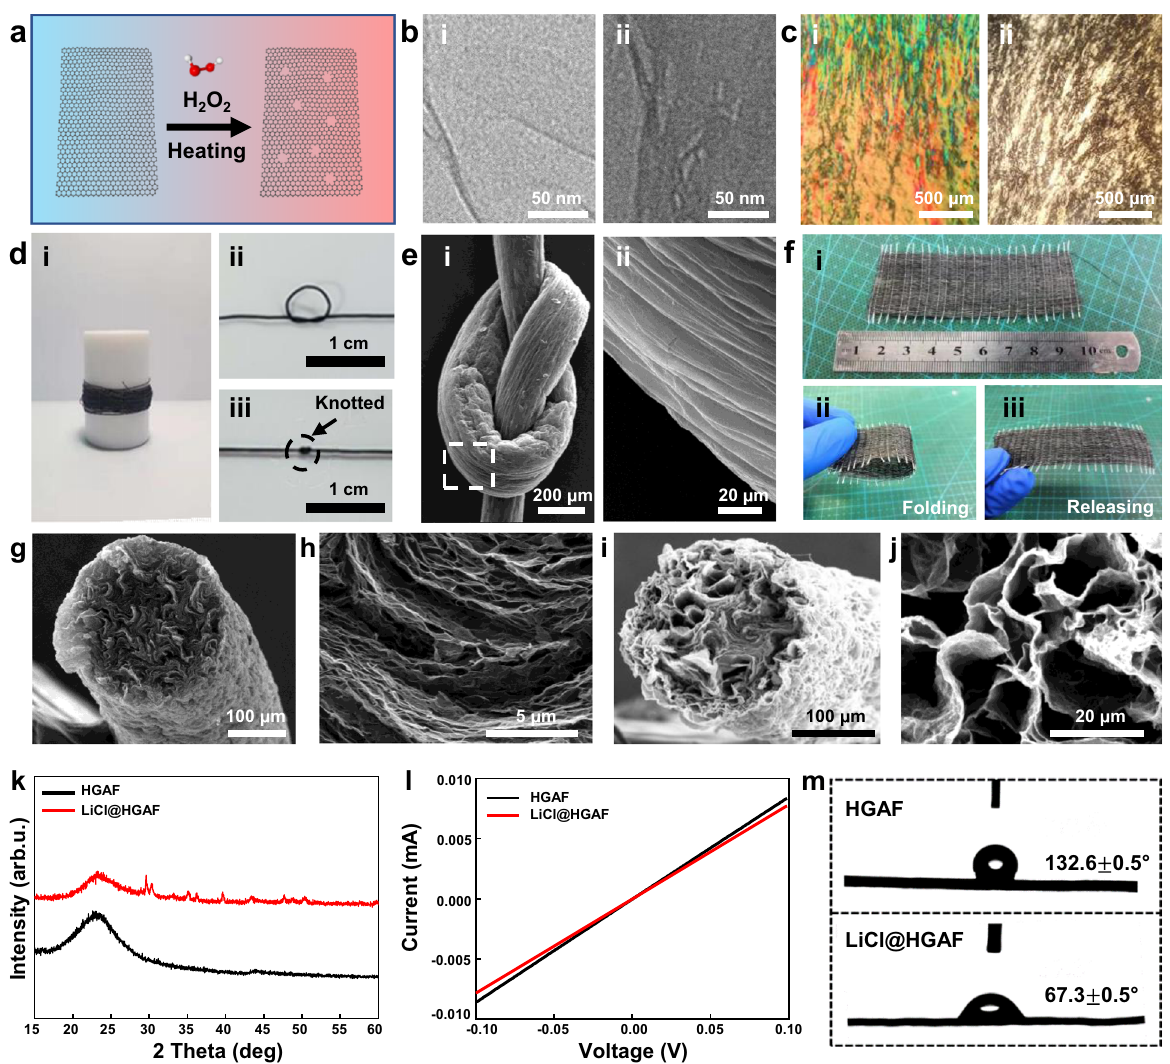
Fig. 2 Characterization of LiCl@HGAFs. a Schematic of the nanopores on graphene oxide formation by H 2 O 2 etching. b TEM images of GO (i) and HGO (ii) sheets. c The optical images of GO liquid crystal (i) and HGO liquid crystal (ii) made from etching GO by H 2 O 2 . d A digital photo of HGAF (i) and knotted HGAF (ii). e SEM images of the knotted holey graphene aerogel fi ber (i) and a partial enlargement of the knot (ii). f Photographs of HGAF based textile (i) and folding test (ii – iii). g , h SEM images of the holey graphene aerogel fi ber. i , j SEM images of LiCl@HGAF-3 (3 wt.% LiCl). k XRD patterns of HGAFs and LiCl@HGAFs. Source data are provided as a Source Data fi le. l I-E curves of HGAF and LiCl@HGAF. Source data are provided as a Source Data fi le. m The water contact angle measurements for HGAF and